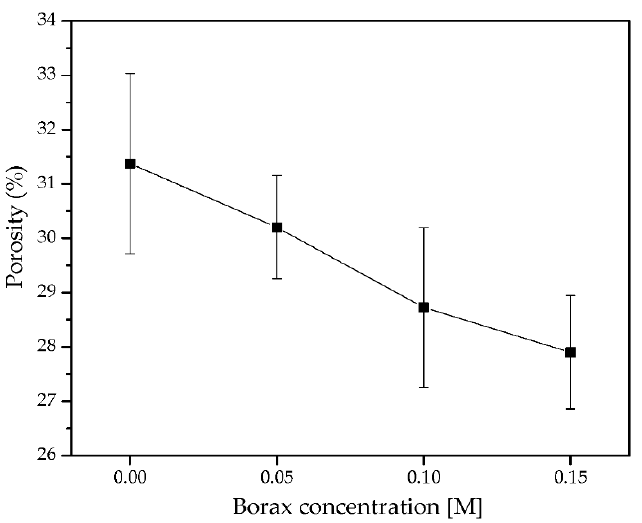
Figure 9. Porosity of DN starch hydrogels prepared at various borax concentrations ( n = 3 ).